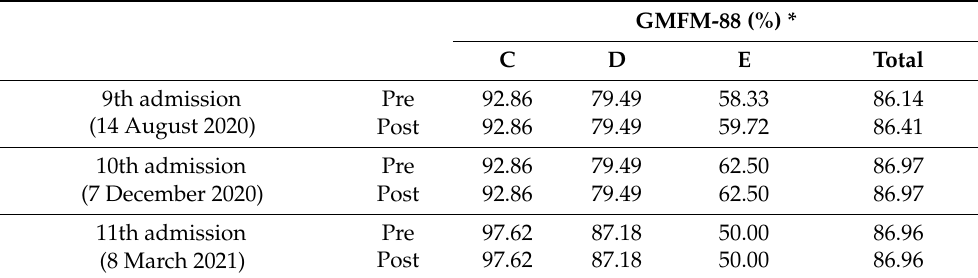
Table 2. Changes in GMFM during the 9th to 11th admissions for case